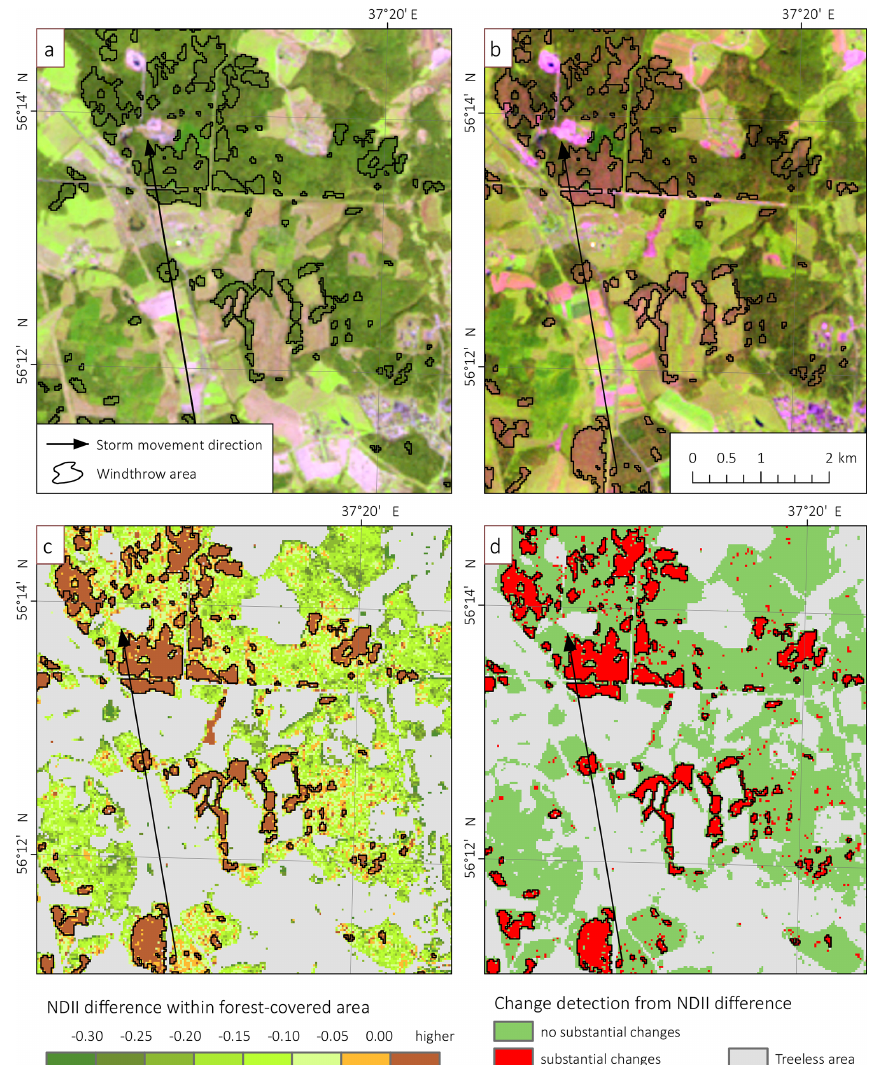
Figure 5. Delineation of windthrow caused by the windstorm that occurred on 21 June 1998 in Moscow region based on the NDII difference method: the Landsat-5 images obtained (a) before and (b) after the storm event on 11 May and 30 July 1998, respectively, (c) the NDII difference within forest-covered area, and (d) the areas with the substantial decrease in the